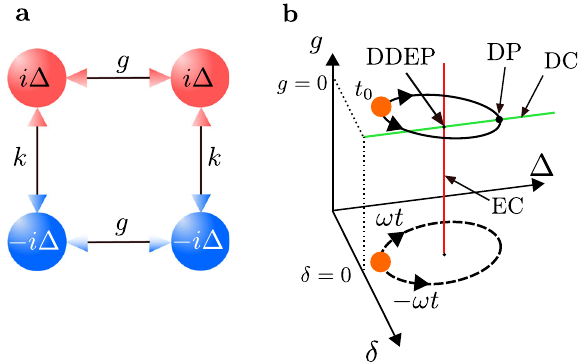
Fig. 1 | Scheme and encircling trajectory space for a four-mode system. a Schematic representation of a four-mode PT -symmetric non-Hermitian Hamil- tonian ^ H , given in Eq. (3). The red (blue) balls represent cavities with gain (loss) rate i Δ ( − i Δ ). Various mode couplings are depicted by double arrows. b The encircling trajectory is described by a loop in the 3D parameter space de fi ned by the dissipation strength Δ , perturbation δ , and coupling g . The clockwise (coun- terclockwise) direction is determined by+ ω ( − ω ). The encircling starts at t 0 at a point in the exact PT -phase (the orange ball). The loop winds around an excep- tional curve, EC (red vertical line), determined by the condition Δ =1 and δ =0. Thetrajectorymaycrossadiaboliccurve,DC(greenhorizontalline),atsomepoint when g =0, i.e., a diabolic point, DP. Moreover, at g =0, a diabolically